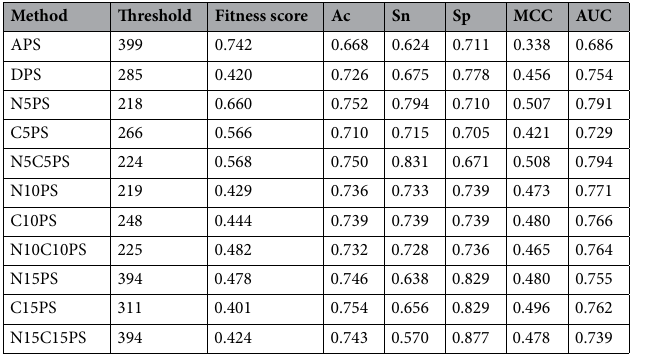
Table 1. Cross-validation results of FSCM models with various types of sequence features as evaluated on the main dataset.